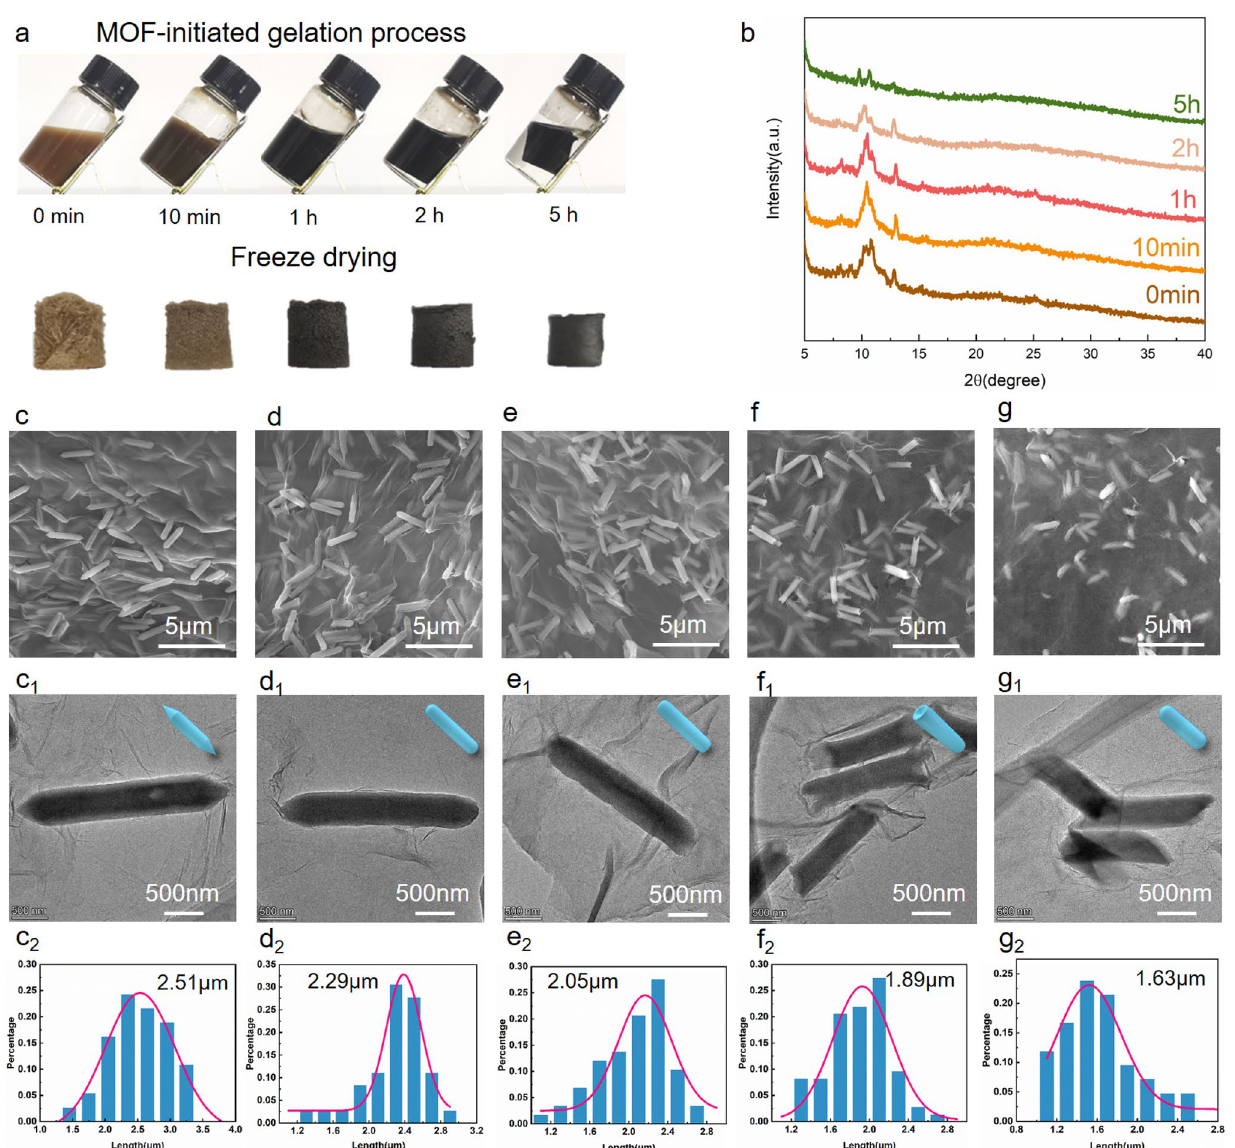
Fig. 2 Representative a images during gelation and freeze drying, b XRD patterns, and c–g rod length distributions based on the SEM and TEM images of MIL-88A/rGO aerogels prepared at different gelation